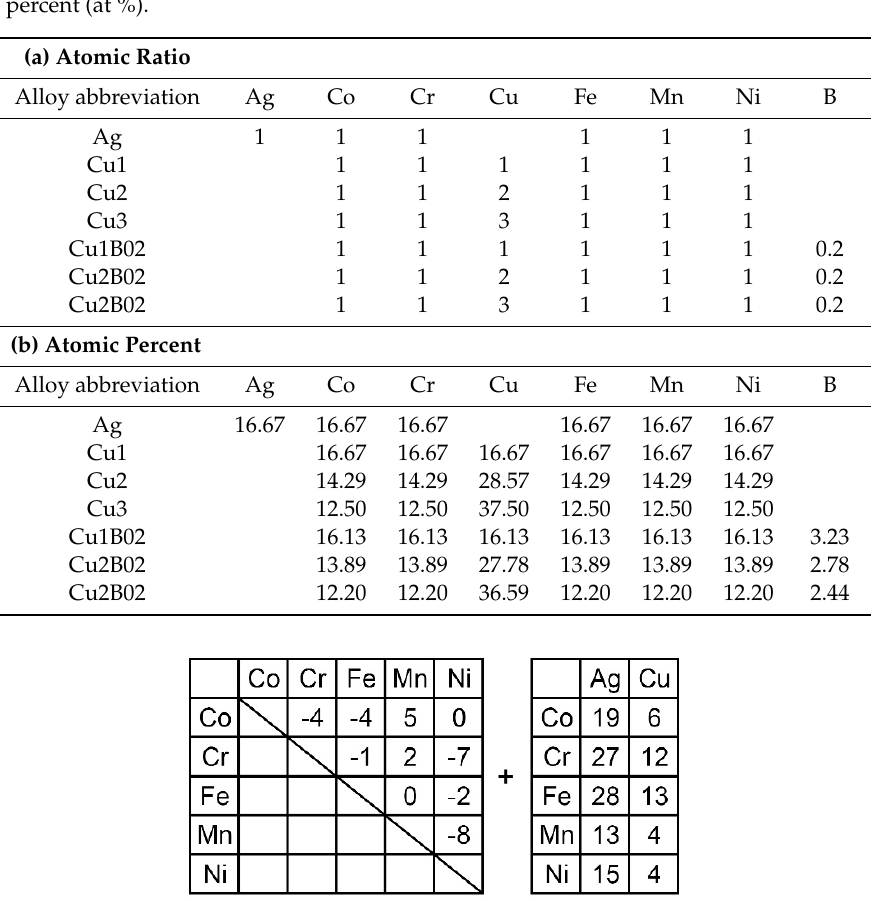
Figure 1. Mixing enthalpy ( ∆ H i-j ) at binary i-j pairs among Ag, Co, Cr, Cu, Fe, Mn, and Ni.